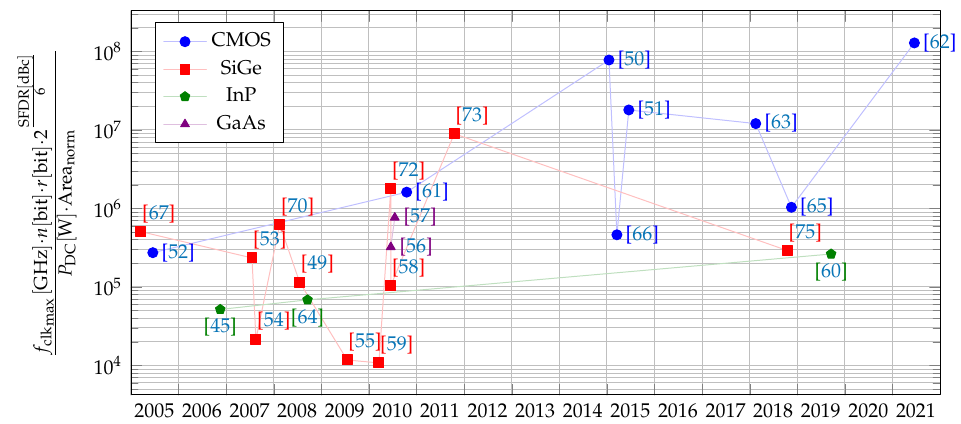
Figure 17. Retained FoM (Equation (15)) versus year and month of publication